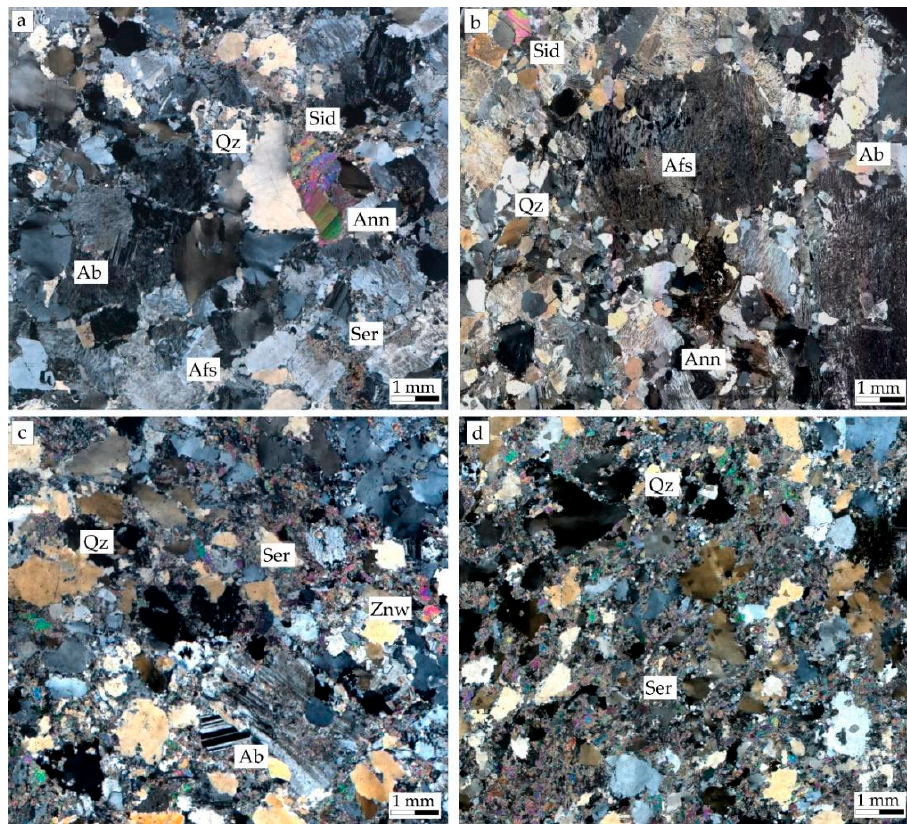
Figure 3. Microscopic aspects of the Desemborque studied rocks. ( a ) Syenogranite with equi- to inequigranular texture, including tabular perthitic alkali feldspar crystals (Afs), sometimes with albitic rims (Ab), as well as rounded and/or elongated quartz (Qz) with undulose extinction and interstitial annite (Ann) crystals. Note the partial alteration of some feldspars by sericite (Ser) and of the annite crystal by siderophyllite (Sid); ( b ) syenogranite with a porphyritic texture involving mesoperthitic alkali feldspars phenocryst in a medium-grained quartz-feldspar matrix; ( c ) greisenized syenogranite displaying inequigranular and altered texture and partial to complete replacement of feldspars by sericite and annite by zinnwaldite (Znw); ( d ) greisen characterized by heterogranoblastic texture with pervasive sericite-silica alteration, high recrystallization of quartz, and extensive replacement of zinnwaldite by sericite. Photomicrographs with crossed polarizers are shown.